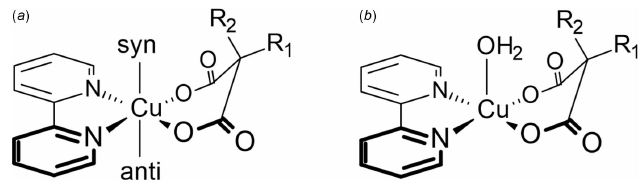
Figure 4 Generalized structures of [Cu(bpy)(malonate)] complexes: ( a ) showing the typical bending of the malonate ligand, with syn and anti coordination sites; ( b ) an example with H 2 O in the syn position, as can occur when R 2 is